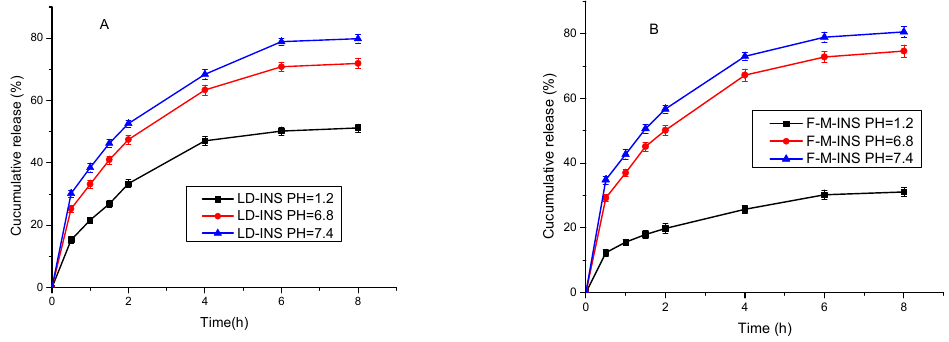
Figure 6. In vitro release of LD-INS ( A ) and F-M-INS ( B ) inclusion complexes.